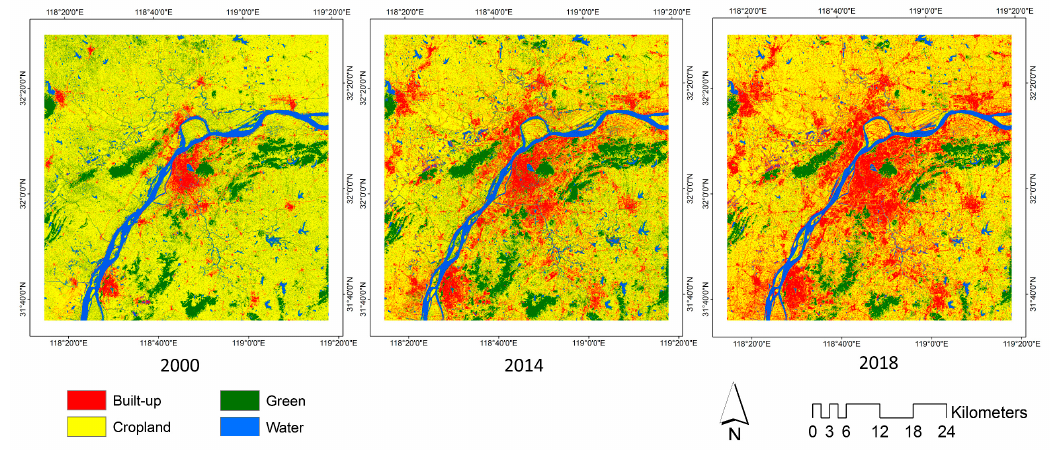
Figure 3. LULC maps of Nanjing in 2000, 2014, and 2018.